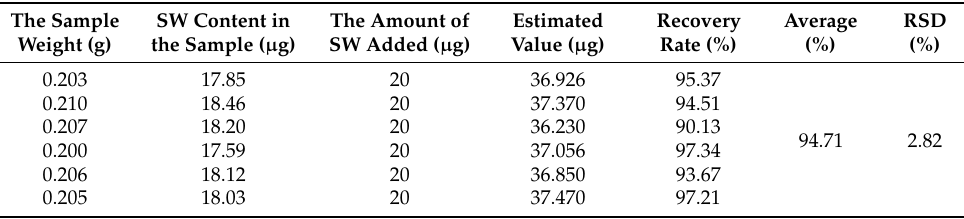
Table 3. Recovery test